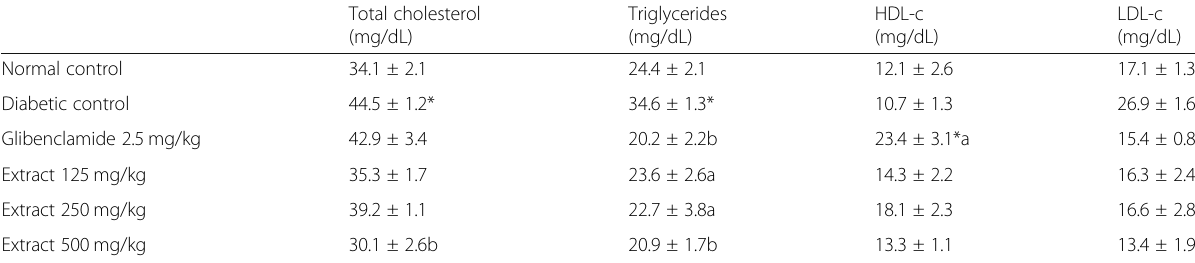
Table 4 Effect of Vitellaria paradoxa on lipid parameters in alloxan-induced diabetes in rats